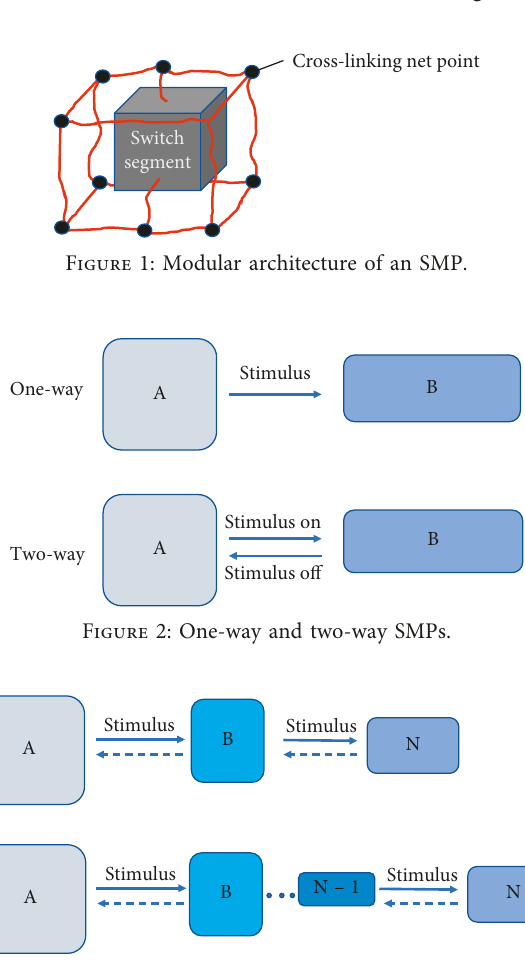
Figure 3: Triple- and